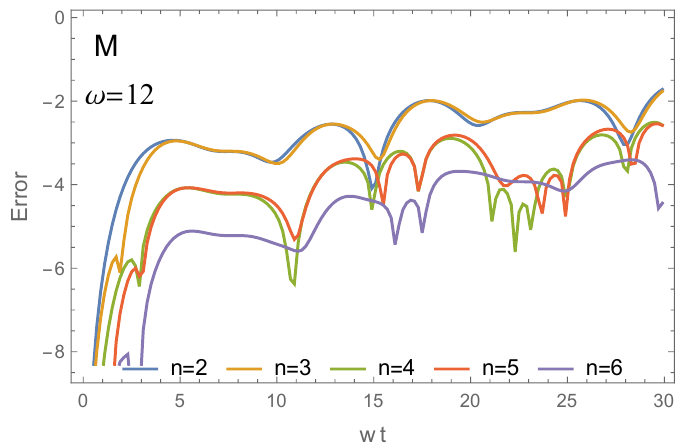
Figure 3. Error (in logarithmic scale) in the transition probability (in logarithmic scale) for the quasi-periodic case (30) as a function of time for FM (left) and Magnus (right) with n = 2 and n = 3 terms in the expansion. In both cases ω = 12 in (30).